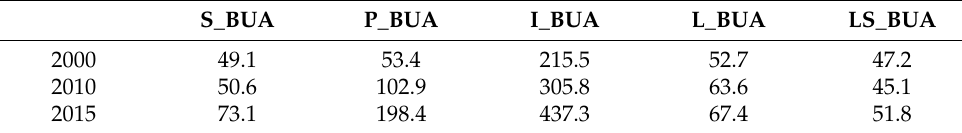
Table 6. The MAE values of built-up area data (km 2 ).